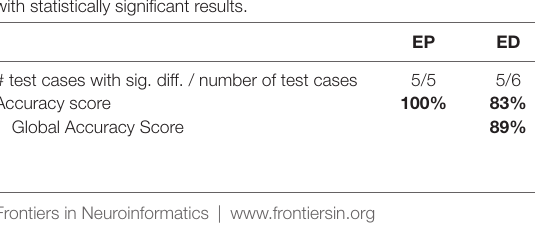
TABLE 6 | Accuracy for each Affect-tag Emotional Indicator based on test cases with statistically significant results. # test cases with sig. diff. / number of test cases